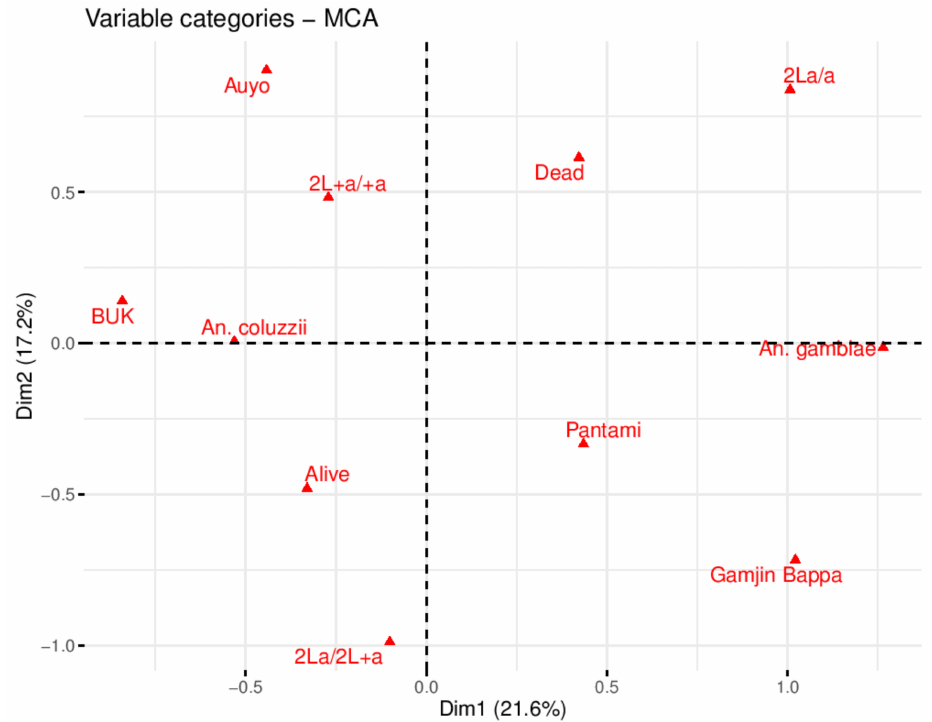
Figure 4. MCA plot of variables from larvae exposed to 44 ◦ C heat stress. Asymmetric/biplot variables on dimensions 1 and 2. Variable categories with similar profiles are grouped together. Negatively correlated variable categories are positioned on the opposite side of the plot origin (opposed quadrants). Variables cluster close to the pole, positive or negative of each dimension indicating how important is their contribution to the